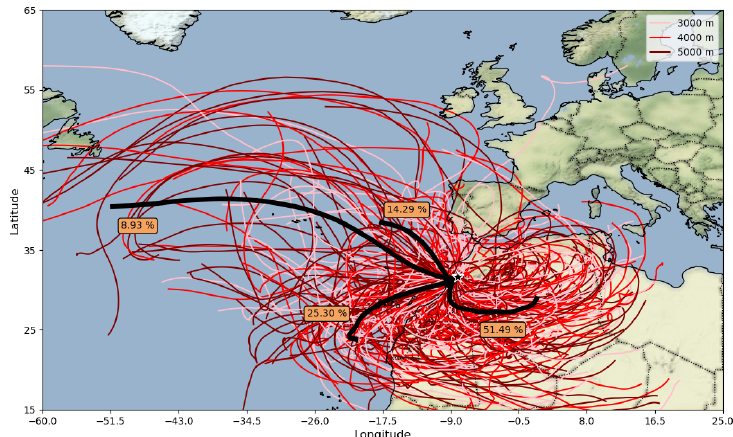
Figure 11. HYSPLIT climatological modelling showing the trajectories of aerosols located over Saada during summer from 2005 to 2020 for upper heights (3, 4 and 5 km). The Saada location is marked with a black star. The black lines correspond to the trajectories obtained via cluster analysis and the percentages represent the ratio of trajectories used for the